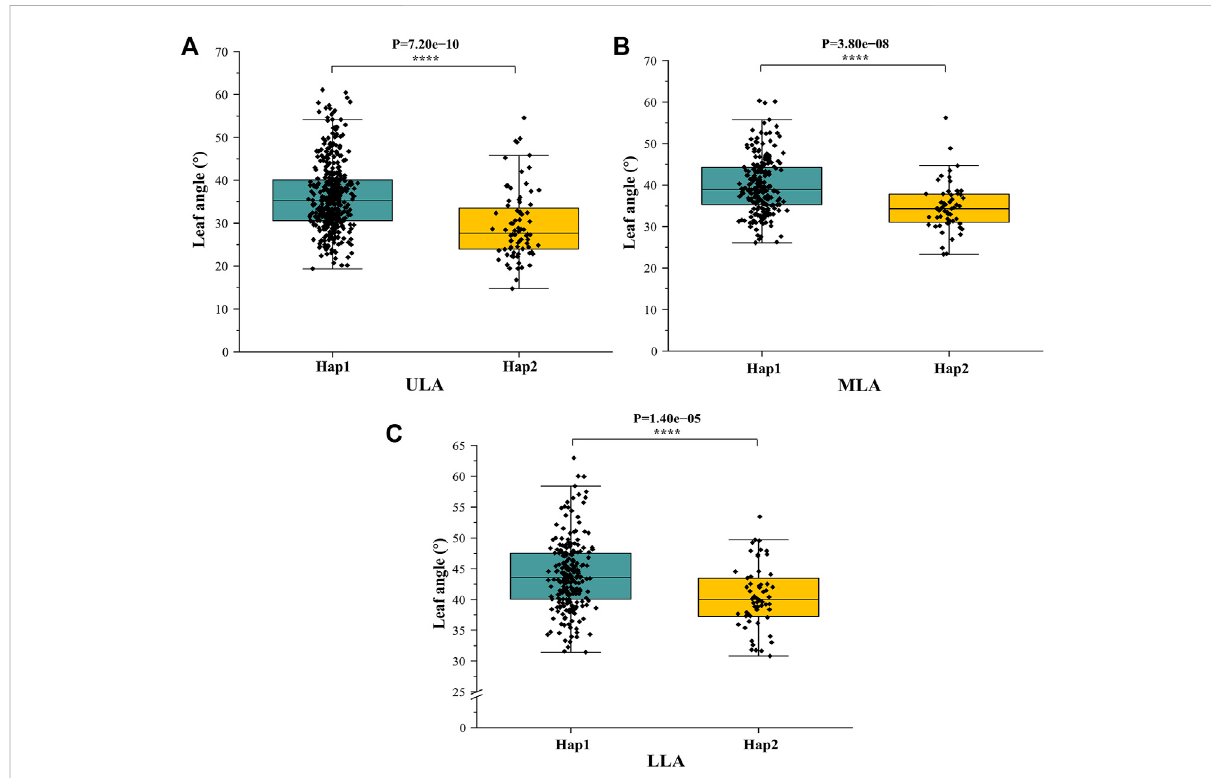
FIGURE 6 Differences in LA-related traits between Hap1 and Hap2. (A) ULA. (B) MLA. (C) (LLA). *: p < 0.05, **: p < 0.01, ***: p < 0.001, ****: p <